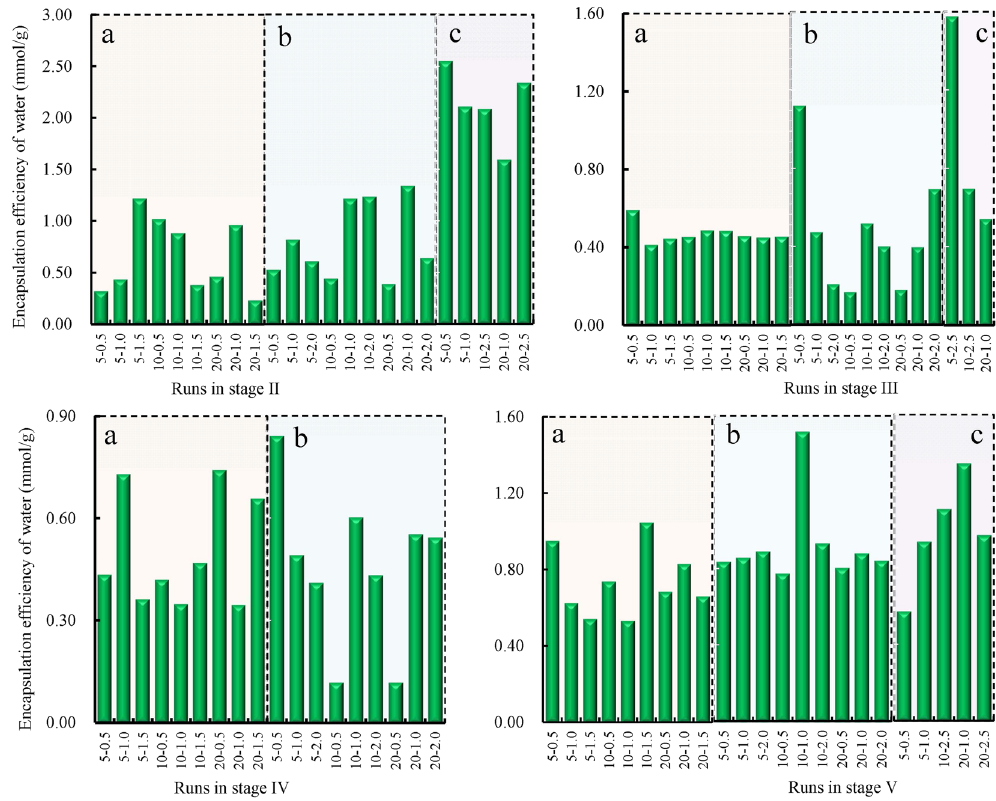
Figure 5. The normal amounts of gas contained in hydrate over stage II–V. Labels ( a , b and c ) corresponds to the experiments at 1.45, 6.49, and 12.91 °C,